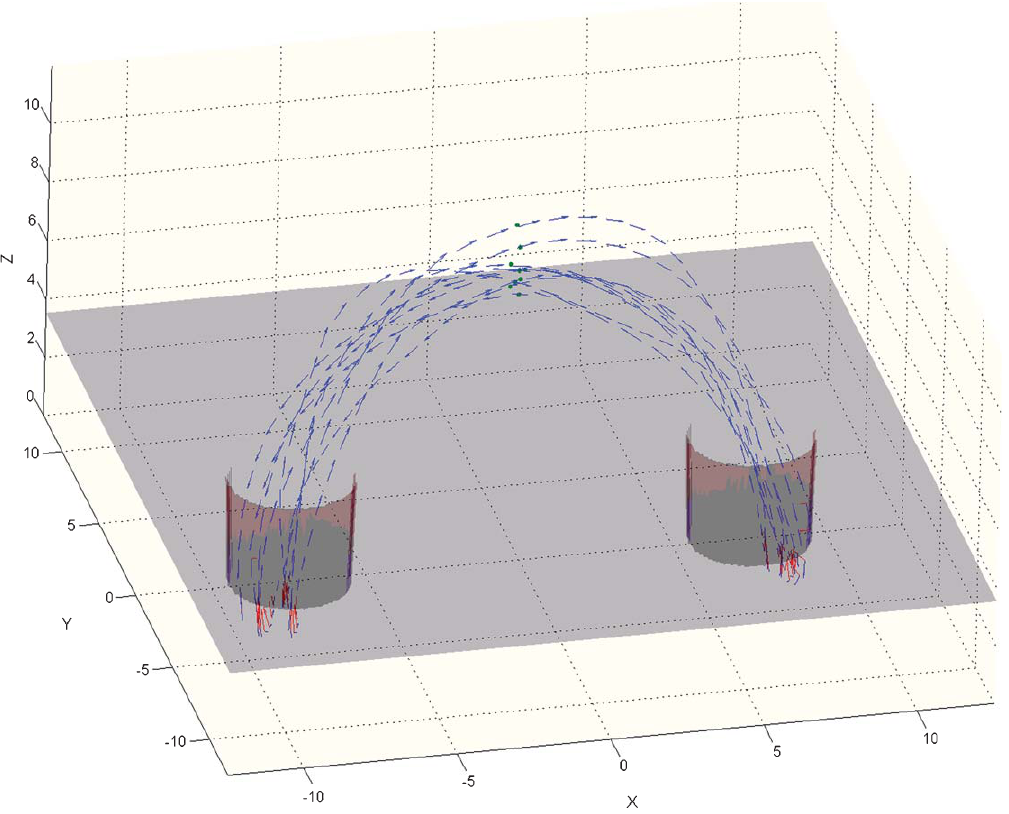
Fig. 4. 3D representation of performance by one of the subjects, analysed using